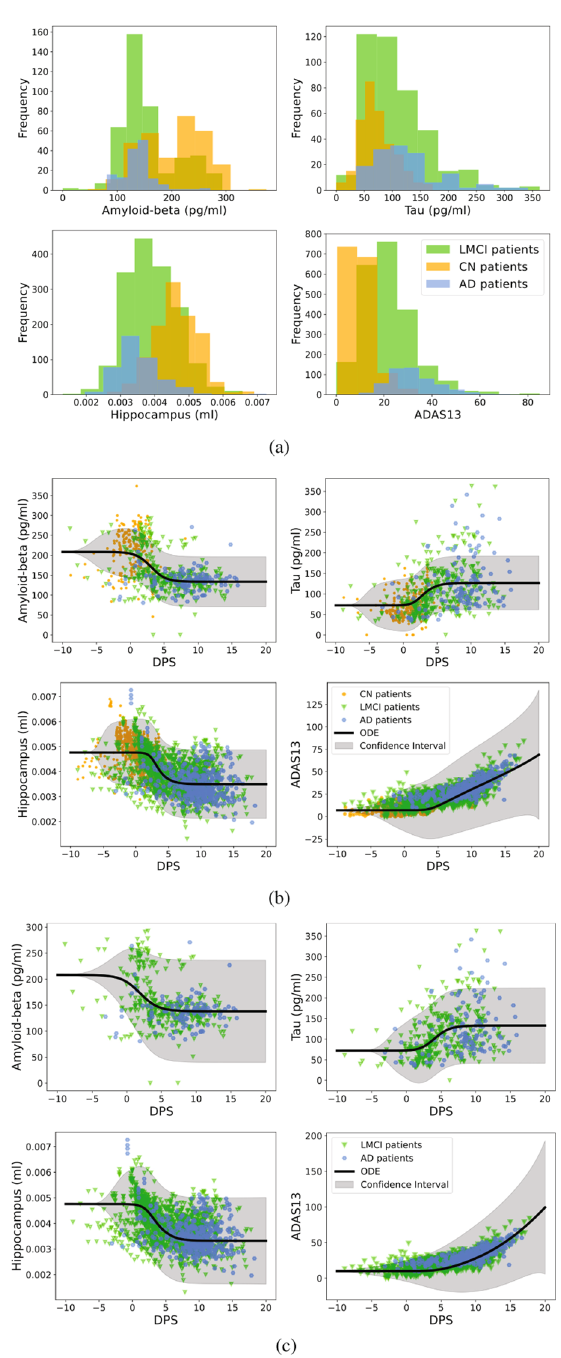
Fig. 1 The ADNI dataset histogram and the calibrated causal model plots. a Histogram of four biomarkers in the ADNI dataset. Top left is amyloid-beta; top right is the tau; bottom left is the normalized hippocampal volume; bottom right is the cognitive subscale. X-axes are the corresponding magnitudes of each biomarker, and y-axes are their frequencies. The subjects are classi fi ed into “ CN ” , “ LMCI ” , and “ AD ” . b The calibrated causal model on three groups of patient data. X-axes are fi tted DPS of biomarkers, and y-axes are the corresponding magnitudes of each biomarker. The orange circles, green triangles, and blue hexagons are data from “ CN ” , “ LMCI ” , and “ AD ” subjects correspondingly. The black solid lines are the solutions of the causal model. c The calibrated causal model on the dataset of LMCI and AD